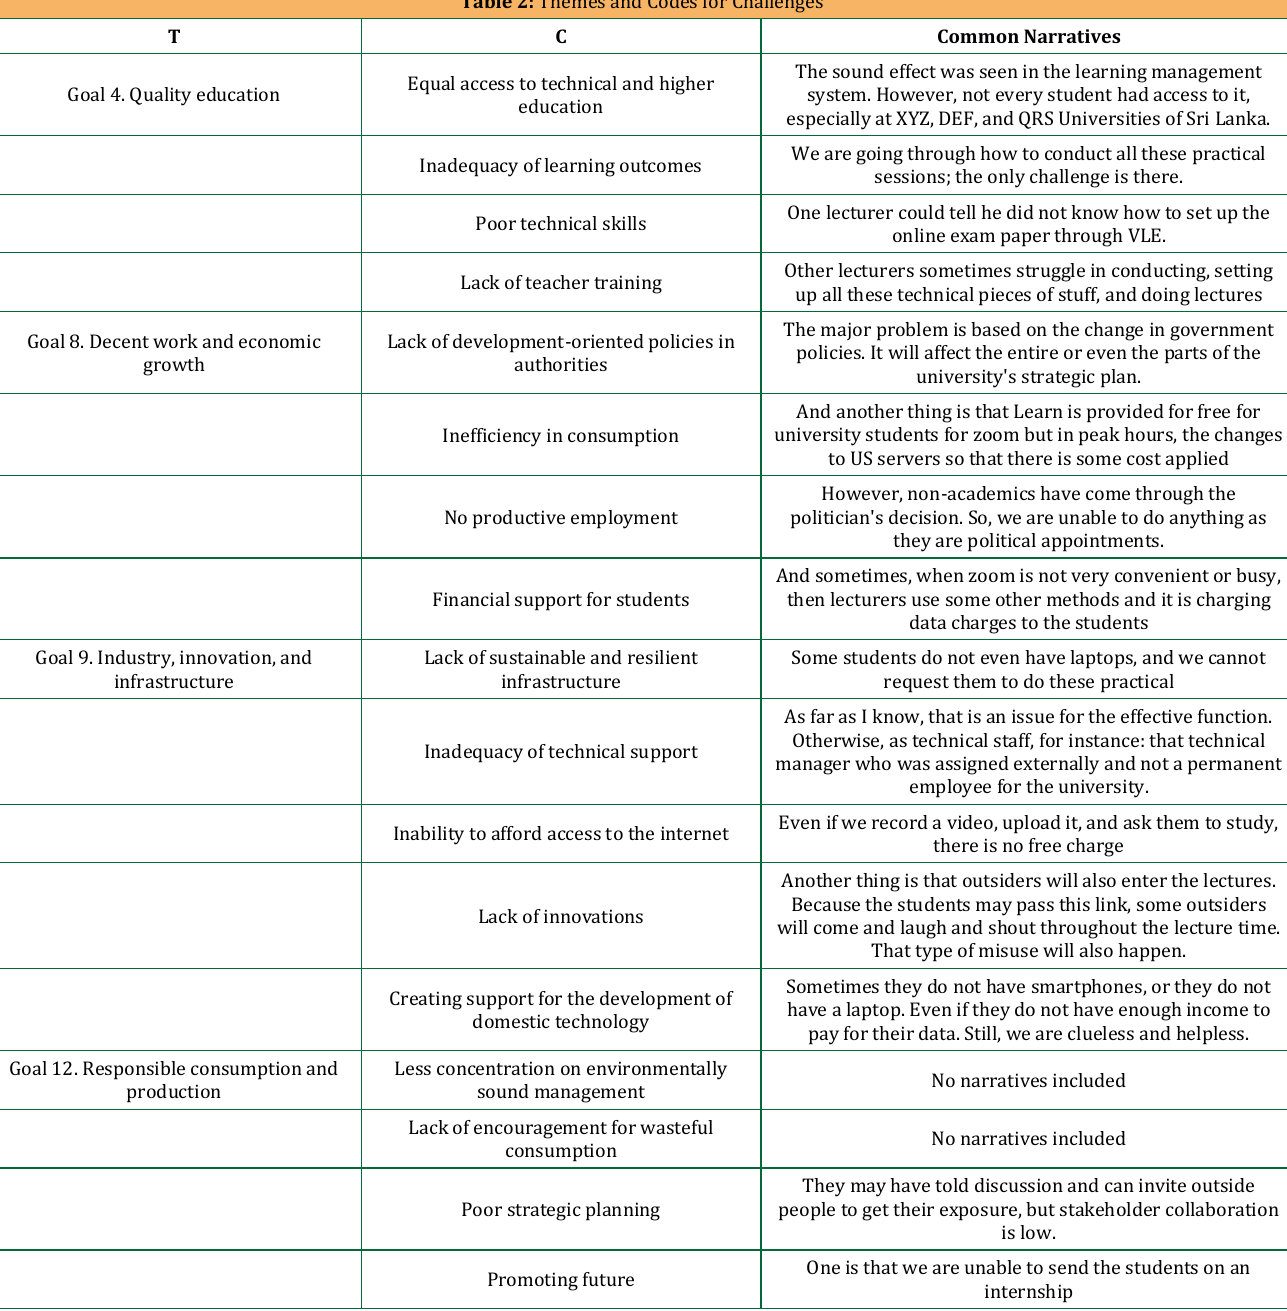
Table 2: Themes and Codes for